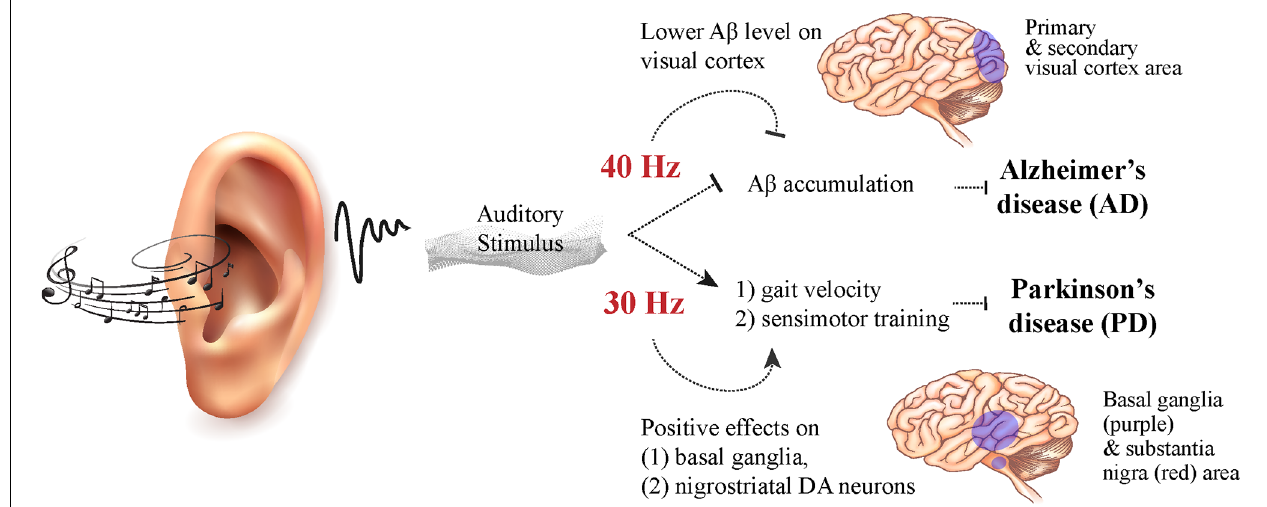
FIGURE 1 | Illustration for the effects of MT-mediated auditory stimulus on neurodegenerative disorders. 40 Hz, as seen as deficient in gamma frequencies in AD patients, has been shown to markedly reduce A β accumulation in the visual cortex of mice. 30 Hz has shown improvement in gait velocity in PD patients. Manipulation of these frequencies in the context of MT or sound-based interventions may provide insight into other forms of treatment for AD and PD.